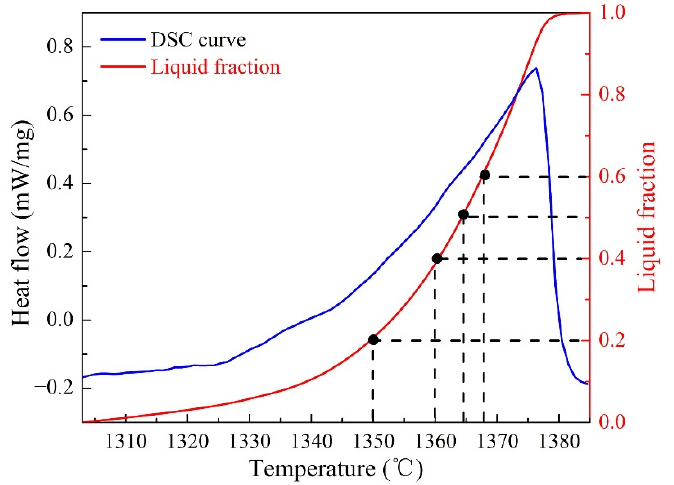
Figure 1. DSC curve and liquid fraction curve of GH3536 alloy.